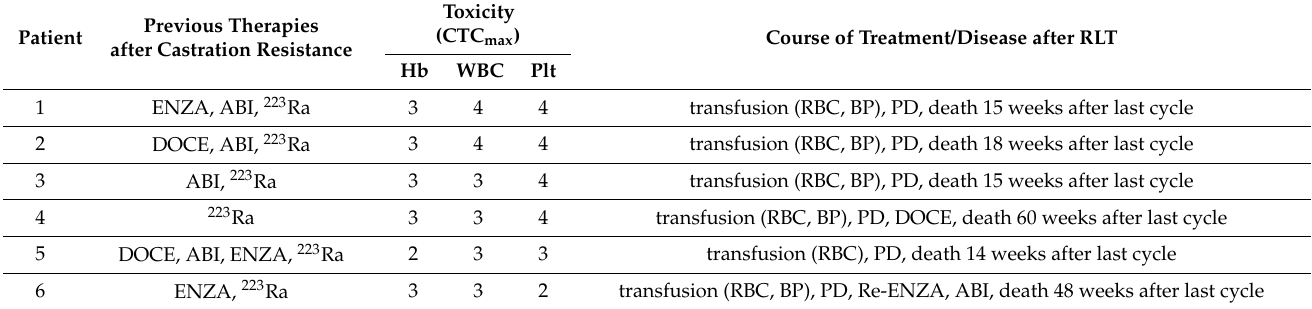
Table 5. Previous therapies and course of six patients with grade ≥ 3 hematologic adverse